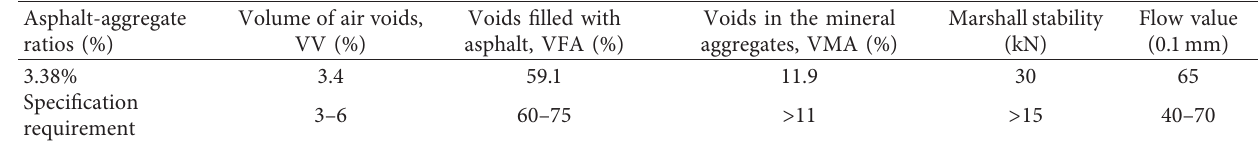
Table 2: Marshall test results at an optimal asphalt content.